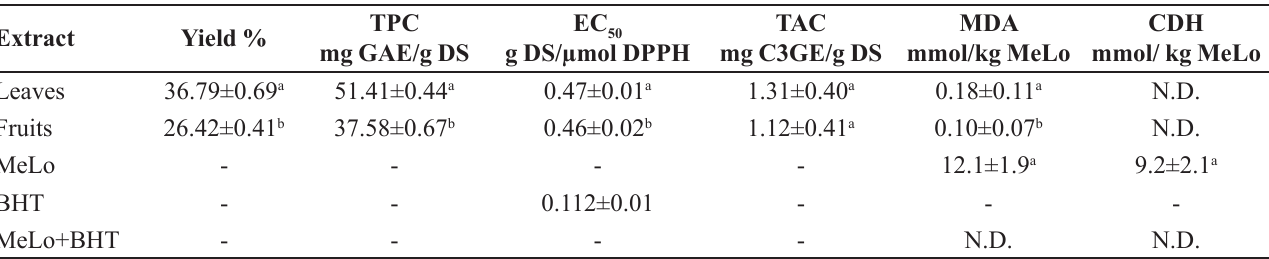
TABLE I - Extraction yield and in vitro antioxidant capacity of M. parvifolia (Benth.) Parra-Os